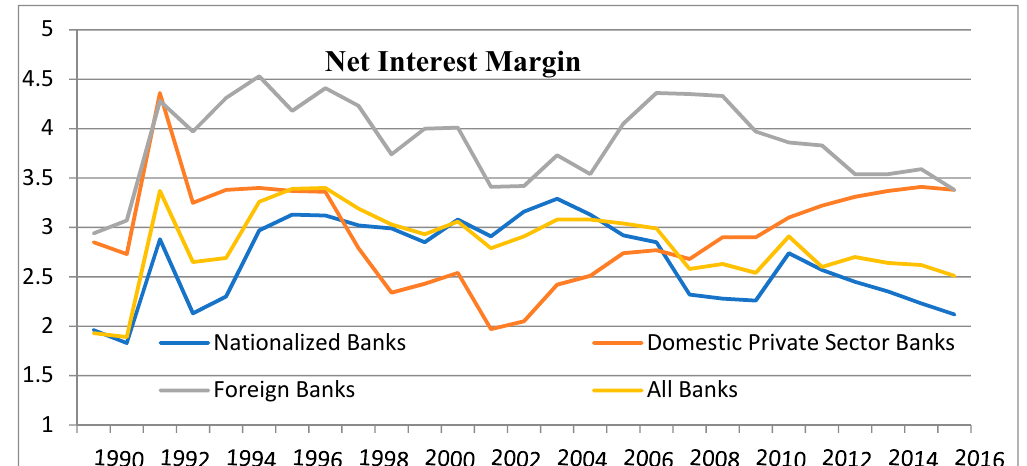
Figure 1. Net Interest Margin for Banks; Source: Reserve Bank of India.